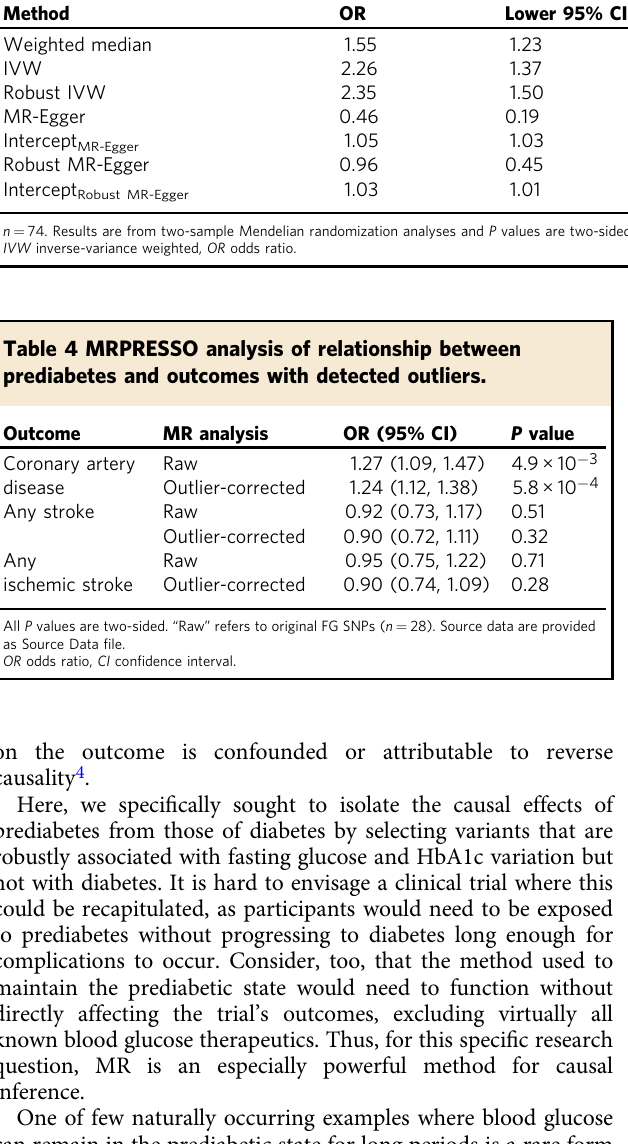
Table 3 Causal association between fasting glucose (all GWA signi fi cant) and risk of T2D. Method